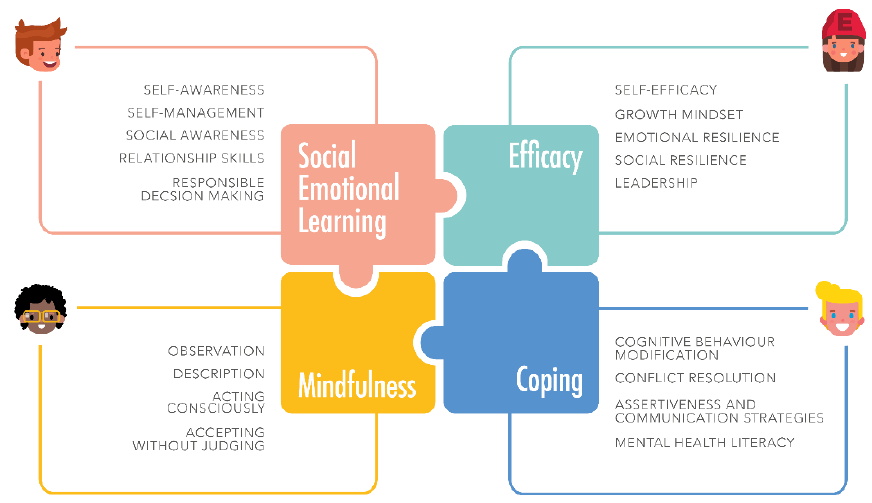
Figure 1. Components and skills of UPRIGHT program.